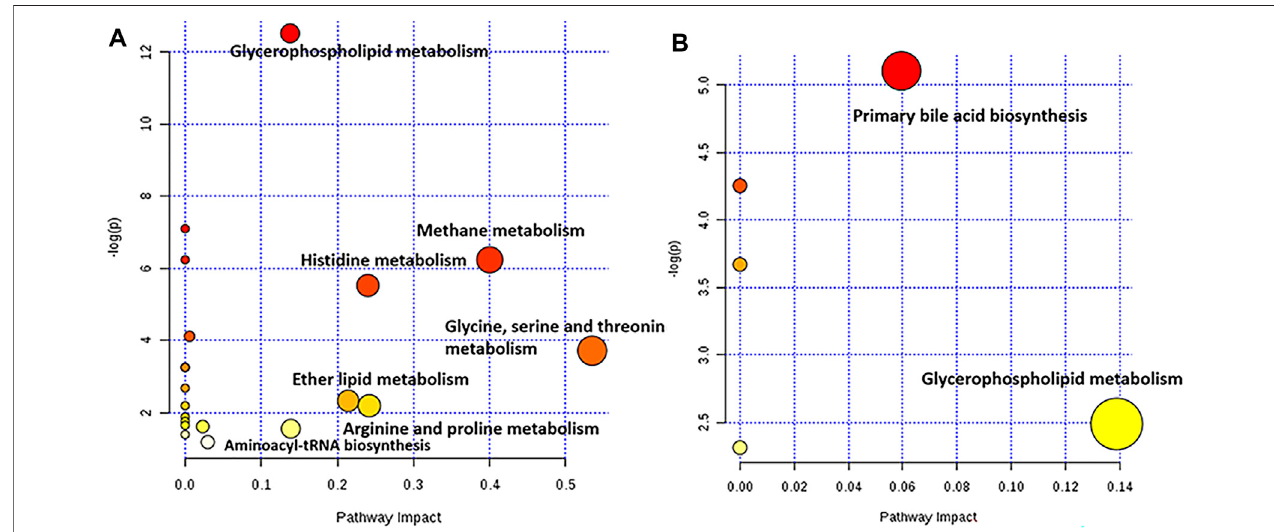
FIGURE6| Pathway analysiswith MetPA. (A) the summary ofthe pathways regulated byPRRin theEHLBSstage. (B) thesummary ofthepathways regulated by PRR in the BS stage. The size and color of each circle was based on pathway impact value and p -value, respectively. The darker of the circle demonstrates that the metabolic pathway is more signi fi cantly regulated by PRR. The larger of the circle represents that the more endogenous metabolites regulated by PRR in this metabolic pathway.